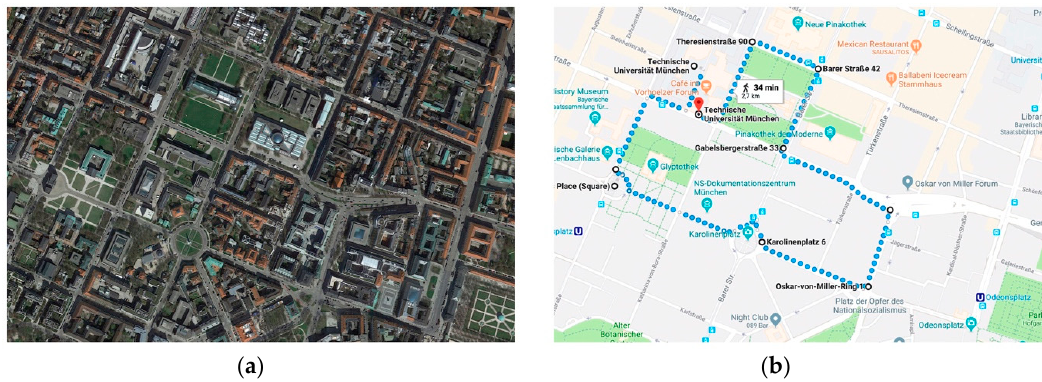
Figure 23. ( a ) Region of assessment in city of Munich; ( b ) the route.